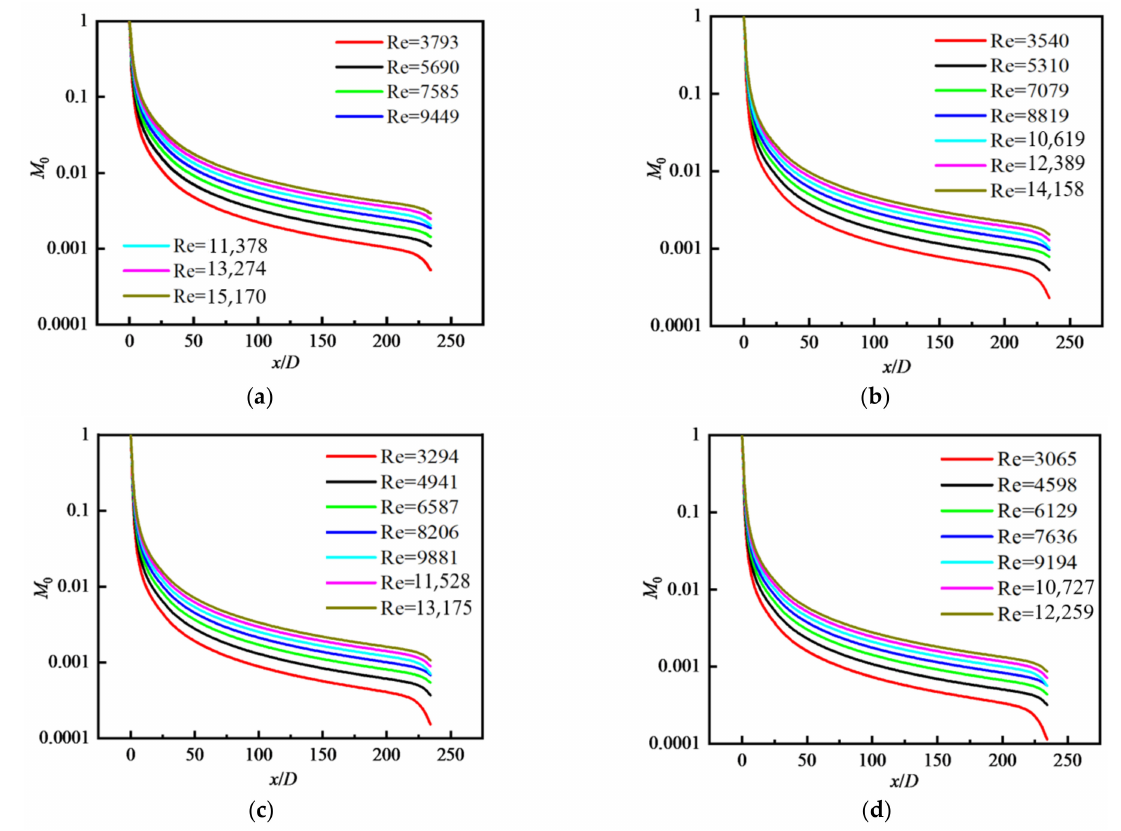
Figure 7. Distribution of M 0 along the flow direction with different ϕ : ( a ) ϕ = 0.01; ( b ) ϕ = 0.02; ( c ) ϕ = 0.03; ( d ) ϕ = 0.04.